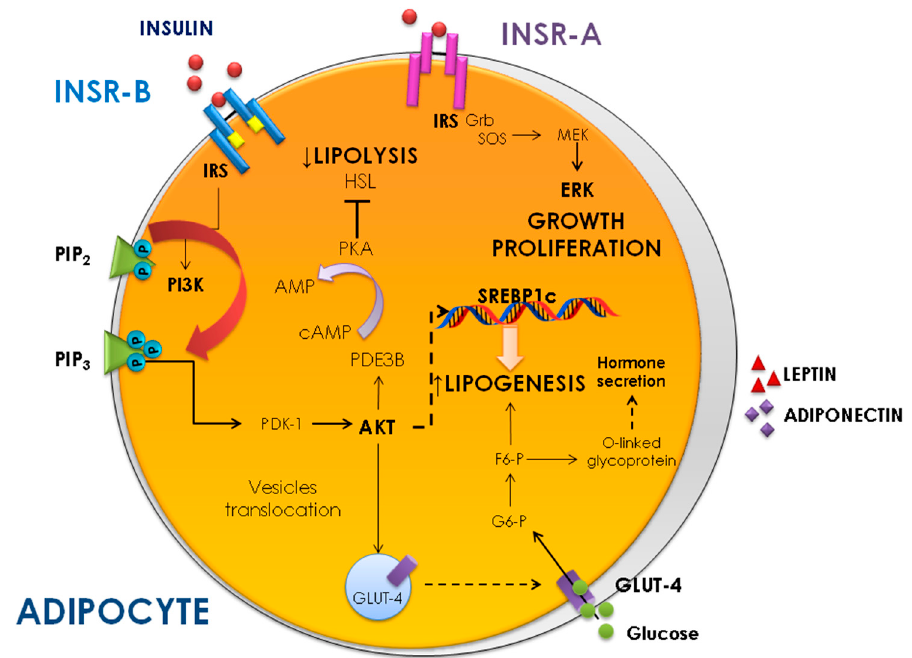
Figure 1. Insulin action in adipocytes. AMP, adenosine monophosphate; cAMP, cyclic adenosine monophosphate; AKT, protein kinase B; F6-P, fructose 6-phosphate; GLUT4, glucose transporter 4; G6-P, glucose 6-phosphate; Grb, growth factor receptor-bound protein; HSL, hormone-sensitive lipase; INSR-A, insulin receptor isoform A; INSR-B, insulin receptor isoform B; IRS, insulin receptor substrate; SOS, Son of sevenless protein; MEK, mitogen-activated protein kinase kinase; ERK, extracellular signal-regulated kinase; PDE3B, phosphodiesterase 3B; PIP 2 , phosphatidylinositol 4,5-bisphosphate; PIP 3 , phosphatidylinositol 3,4,5-triphosphate; PI3K, phosphoinositol 3-kinase; PDK-1, phosphoinositide dependent kinase 1; PKA, protein kinase A; SREBP1c, sterol regulatory element-binding protein 1.